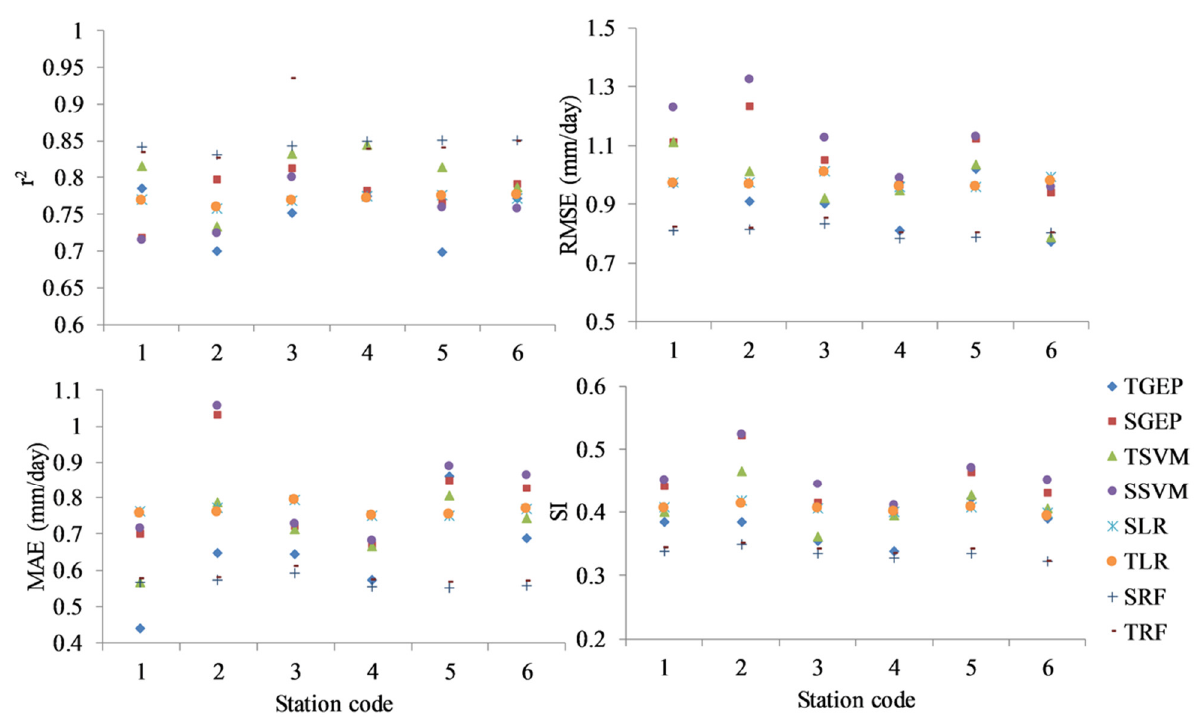
Figure 2. Statistical indices of the temperature-based combination for the four applied models (GEP, VM, LR, and RF) with local (T) and spatial (S) approaches.